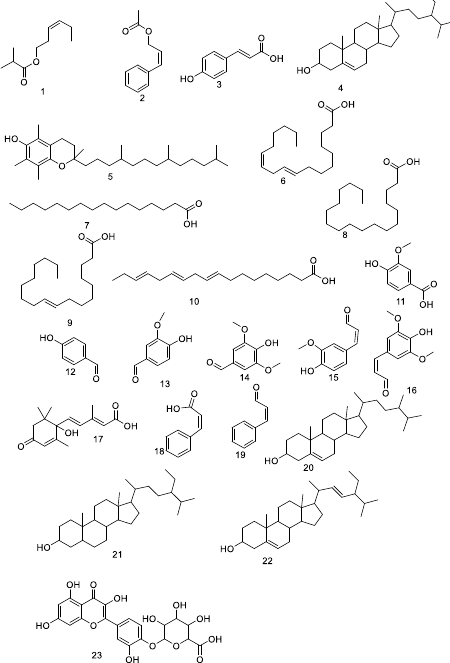
Figure 1. Putative compounds identified from Psidium guajava seed.